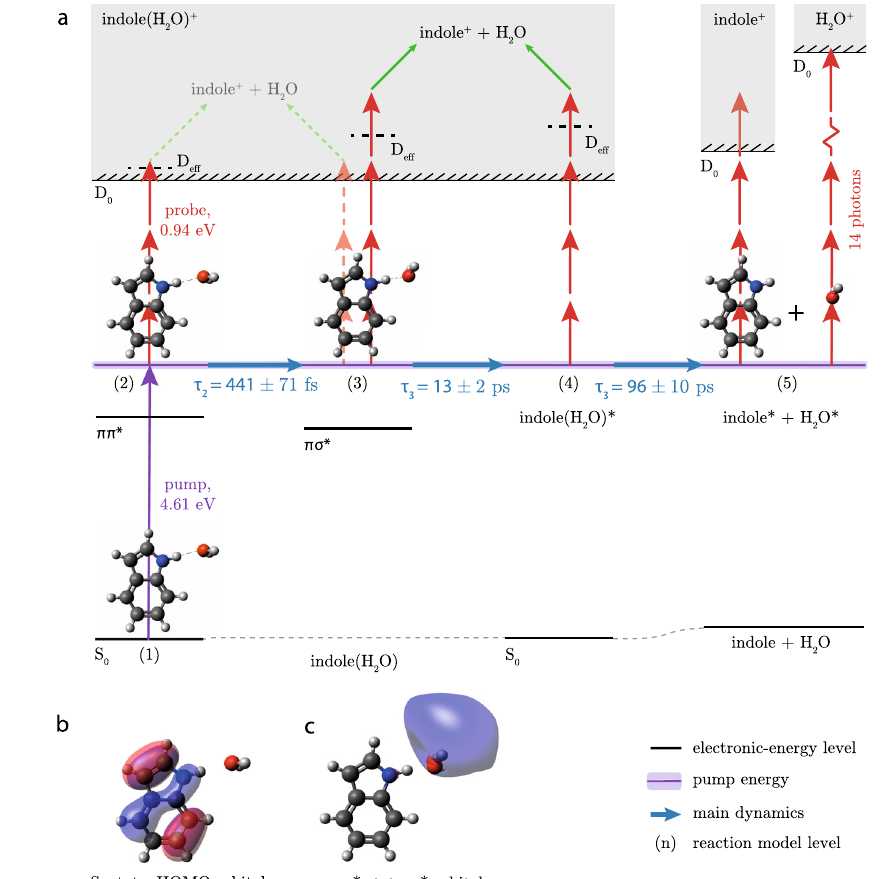
Fig. 3 | Schematic of the UV-induced photochemistry in indole(H 2 O). a The purple arrow indicates the UV pump-photon energy yielding the overall energy in the system after absorption of anUV photon, indicated by the purpleline, whichis conserved throughout the dynamics. The shaded purple area represents the cor- responding bandwidth. Blue horizontal arrows depict the different steps in the observed photochemistry with corresponding timescales; see text for details. The redarrowsindicatetheabsorptionofNIRprobephotonsleadingtoionisation.The black dashed lines labelled D eff represent the cationic states that need to be accessed to ef fi ciently ionise from a particular initial state in indole(H 2 O); see text